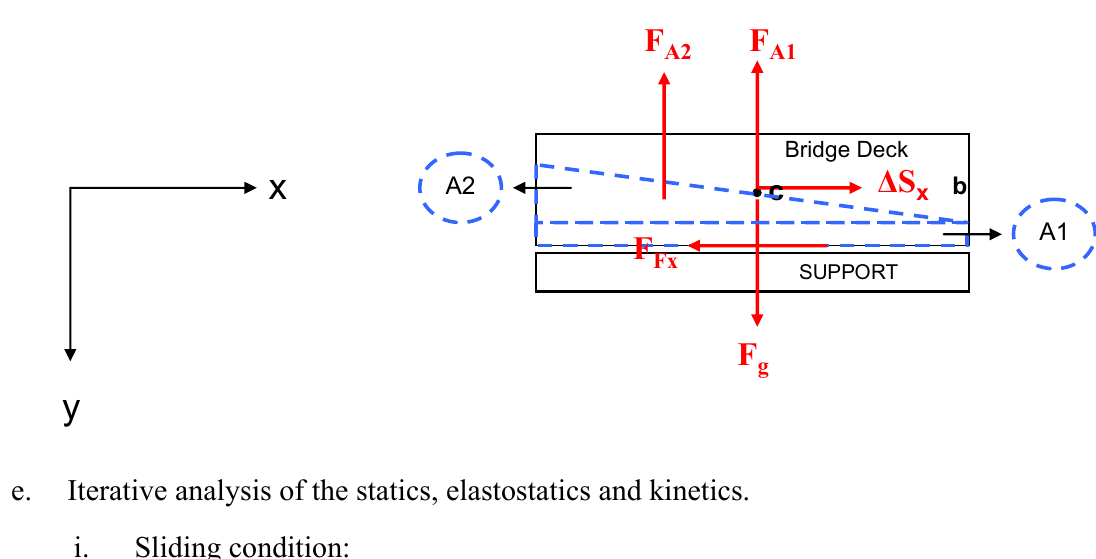
Figure 3. Free body diagram of the bridge deck impacted by the